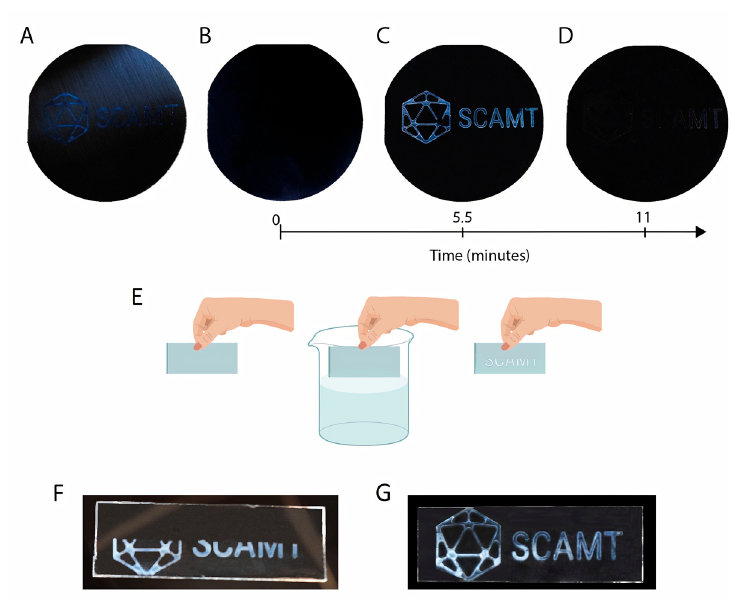
Figure 7. The photos of printed PS colloid on a silicon wafer ( A ), the PS–CS hydrogel before humidity changes ( B ) image appearance after water addition ( C ), and hydrogel after complete drying ( D ). ( E ) Schematic illustration of the process of image appearance after water interaction. The photos of a hydrogel sample on a glass slide after half of the sample was submerged in water ( F ) and after the whole sample was submerged in water ( G ).